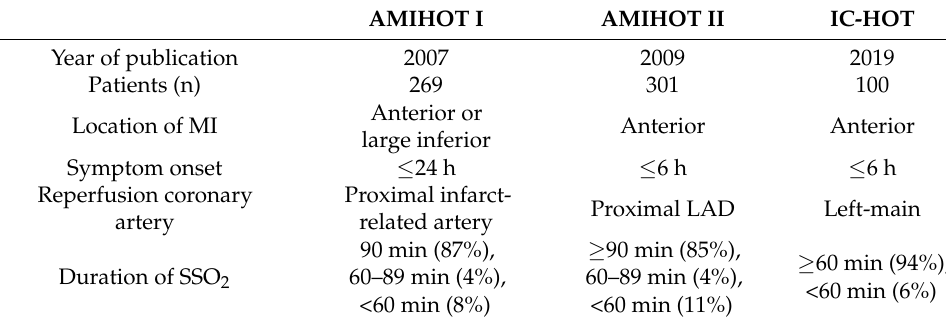
Table 2. Clinical trials usin hyperoxemic therapy in acute myocardial